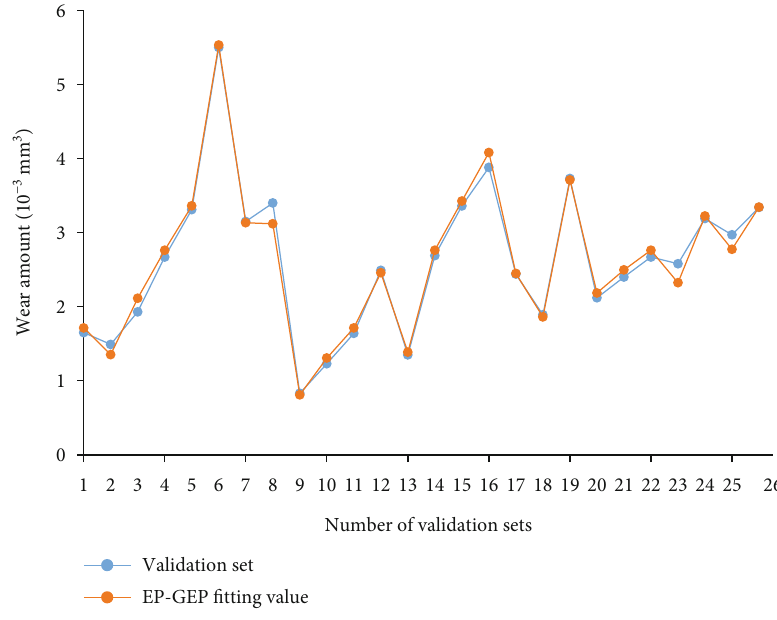
Figure 9: Comparison of wear amount of veri fi cation set and EP-GEP prediction value.